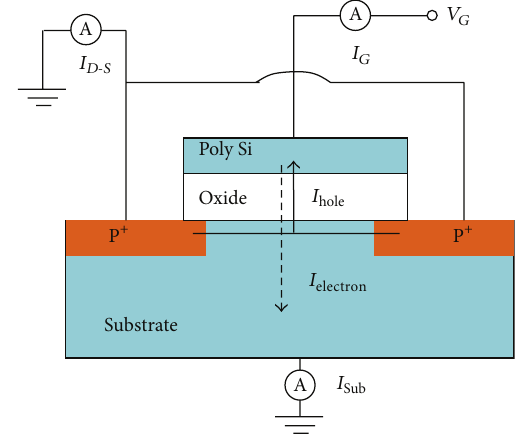
Figure 2: Configuration of the circuit diagram in carrier separation measurements. The gate electrode is biased for the stress condition, and drain and source electrodes are connected